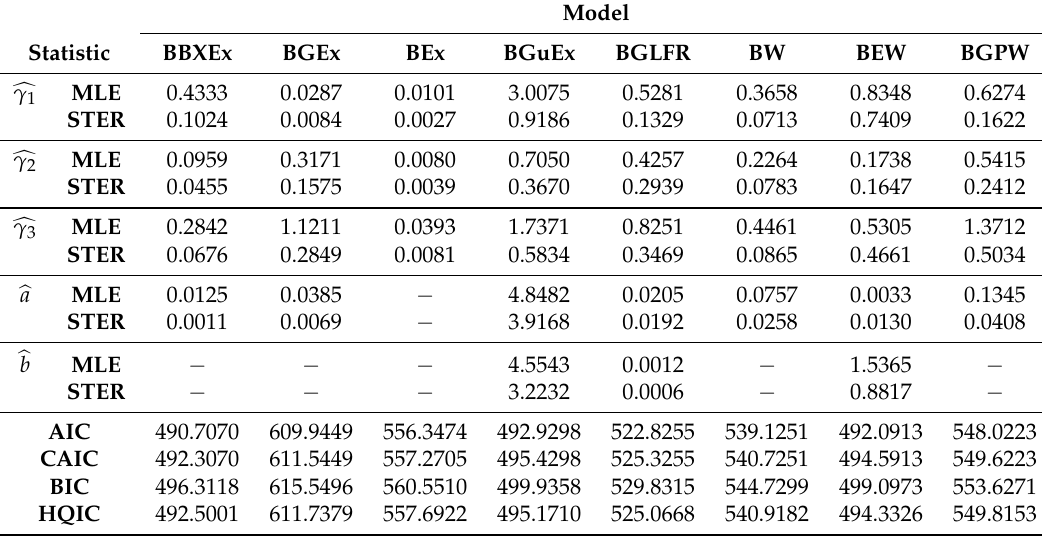
Table 11. The MLEs and goodness-of-fit measures based on Type-II censored data at r = 30 using data set I.